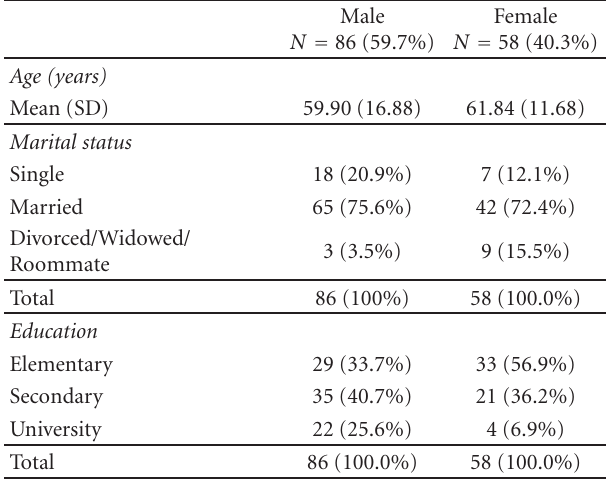
Table 1: Sociodemographic characteristics of the sample ( N =